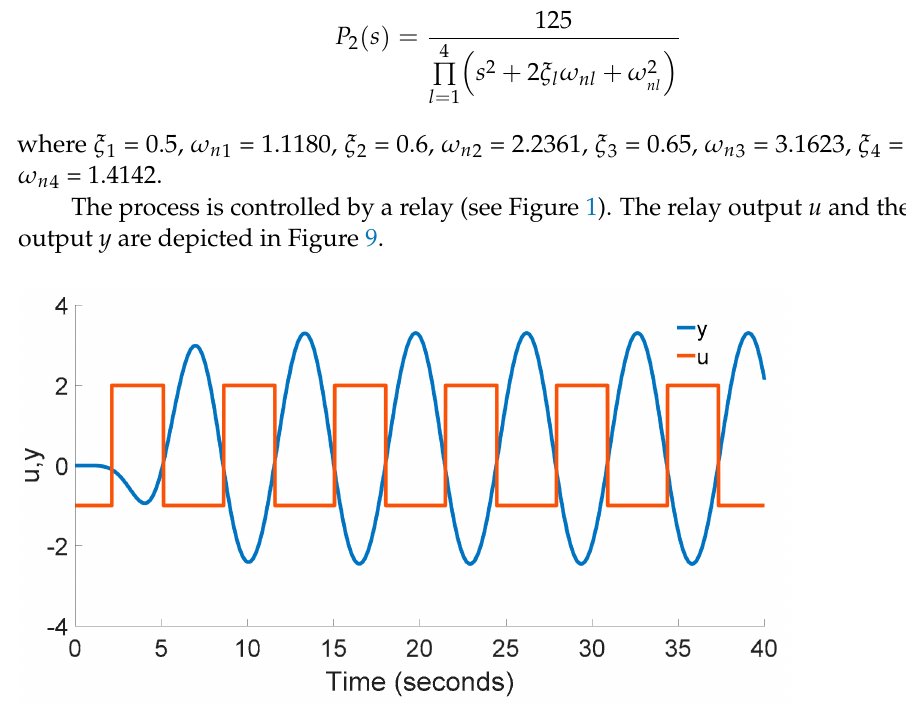
Figure 9. The relay output u and the observed output y of the process P 2 ( s